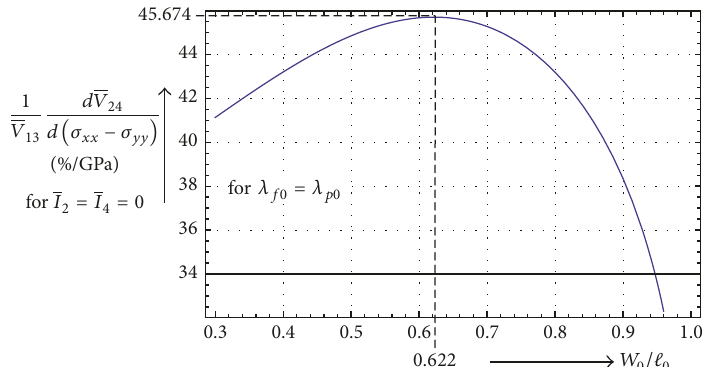
Figure 8: Sensitivity of output voltage 𝑉 24 versus mechanical stress 𝜎 𝑥𝑥 − 𝜎 𝑦𝑦 (normalized to supply voltage 𝑉 13 ) for an offset-free device of Figure 6 operated in the same way as in Figure 6. All other components of the stress tensor vanish, as well as 𝜎 𝑥𝑥 + 𝜎 𝑦𝑦 = 0 . The plot is a graphical representation of (18a)–(18m) in the limit of small stress and with the piezoresistive coefficient 𝜋 44 = 1.381/ GPa for low p-doped silicon. Largest stress sensitivity of 45.674%/GPa is obtained for aspect ratios 𝑊 0 /ℓ 0 ≈ 0.622 . There 𝑠 0 /ℓ 0 ≅ 0.1315 satisfies (20).